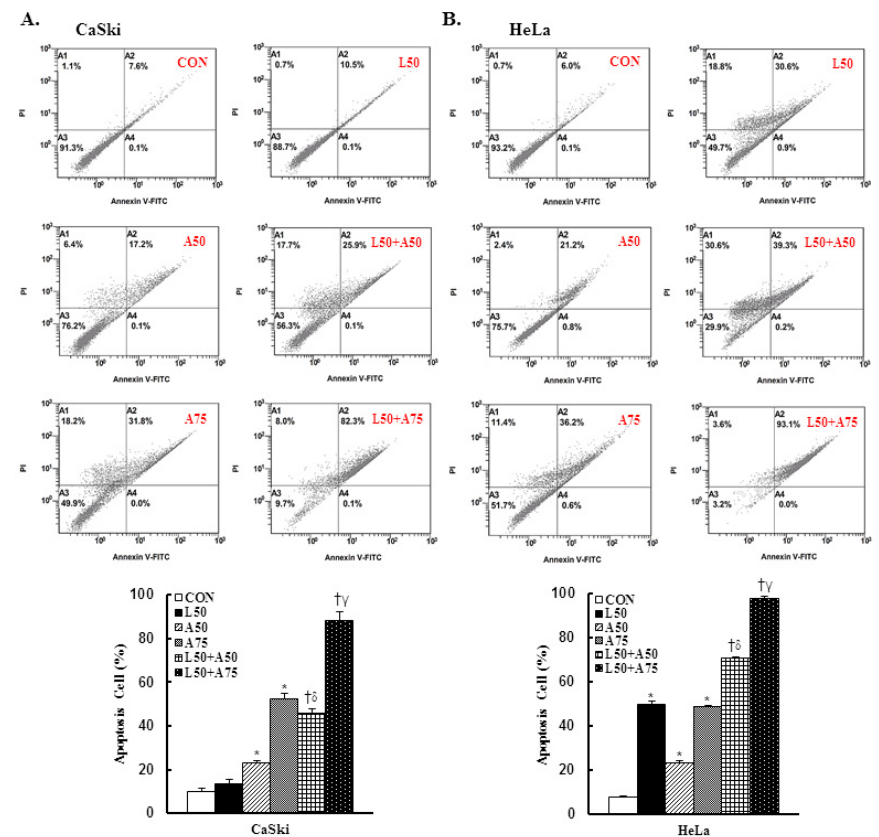
Figure 2. The combination of luteolin and asiatic acid induced greater apoptosis in CaSki and HeLa cells. CaSki and HeLa cells were analyzed using flow cytometry after 24 h of treatment with Lut (50 μ M) or AsA (50 and 75 μ M) alone or in combination. Representative flow cytometry dot plots (upper panel) and histograms (lower panel) reveal cell apoptosis (Annexin V- and PI-stained cells) and quantitative analysis for ( A ) CaSki and ( B ) HeLa cells. Values represent mean ± SD from three replicates. *, †, δ and γ p < 0.05 compared with CON, L50-, A50- or A75-treated group. CON,